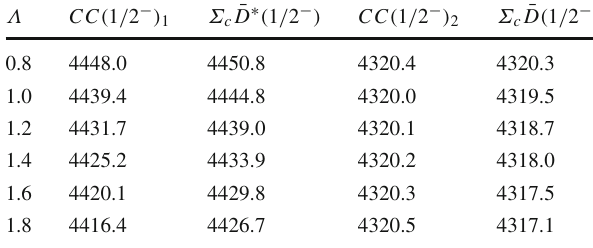
Table 2 The position of the bound states with J P = 1 / 2 − in a unit of MeV. The Λ in the unit of GeV is the cutoff in the exponential regularization in Eq. (9). The CC means coupled-channel calculation and Σ c ¯ D ∗ and Σ c ¯ D meanthecorrespondingsingle-channelcalculation